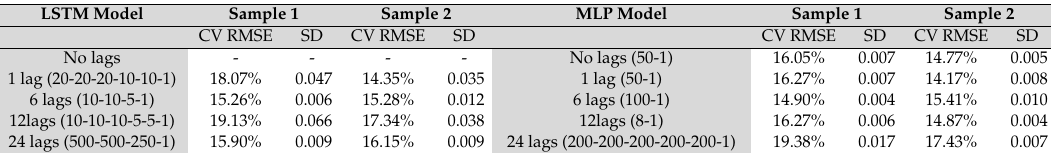
Table 2. Results of the thermal demand predictions based on the time lags introduced in the neural network model. LSTM errors are presented in the first three columns, whereas MLP errors are presented in the last three. The results shown summarize the 10 repetitions of the experiment, for each architecture and each sample analyzed. The mean of the CV(RMSE) obtained in each of them and the standard deviation (SD) are presented. The di ff erent structures of the neural networks that obtain the best accuracy are presented between